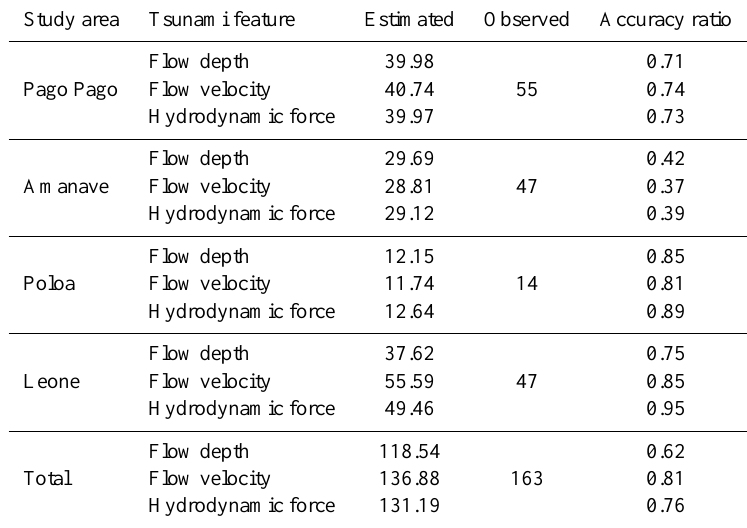
Table 5. Numbers of destroyed buildings estimated by the developed fragility